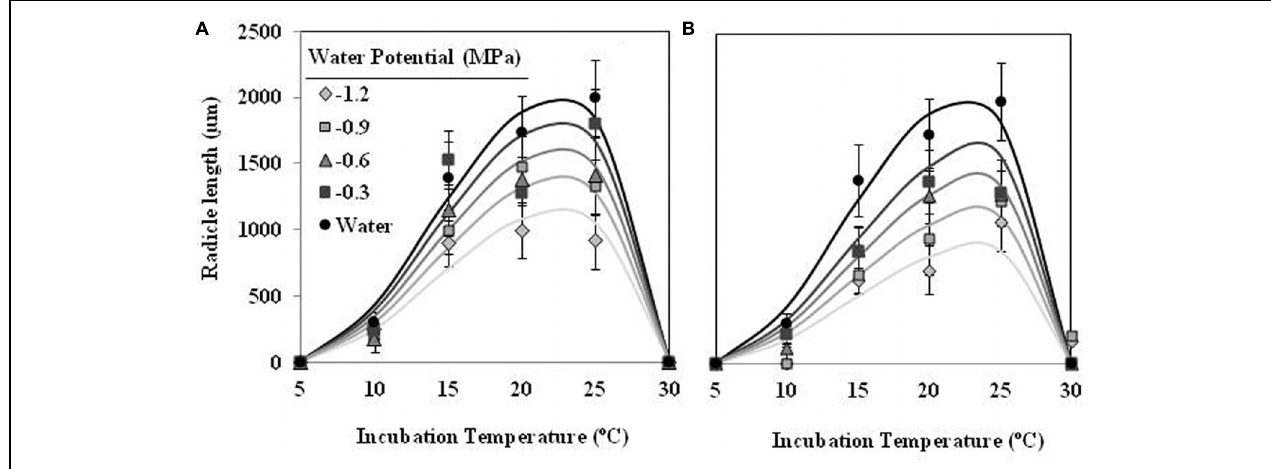
FIGURE 6 | Effects of temperature ( ◦ C) and matric (A) or osmotic (B) potentials (MPa) on radicle length of O. crenata seeds during incubation period. The lines were fitted according to Analysis β equation (Hau and Kranz, 1990; Table 1 ). Points represent the average of six repetitions. Bars represent the SD of the